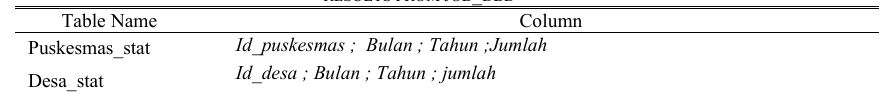
TABLE 8 RESULTS FROM JOB _ DBD